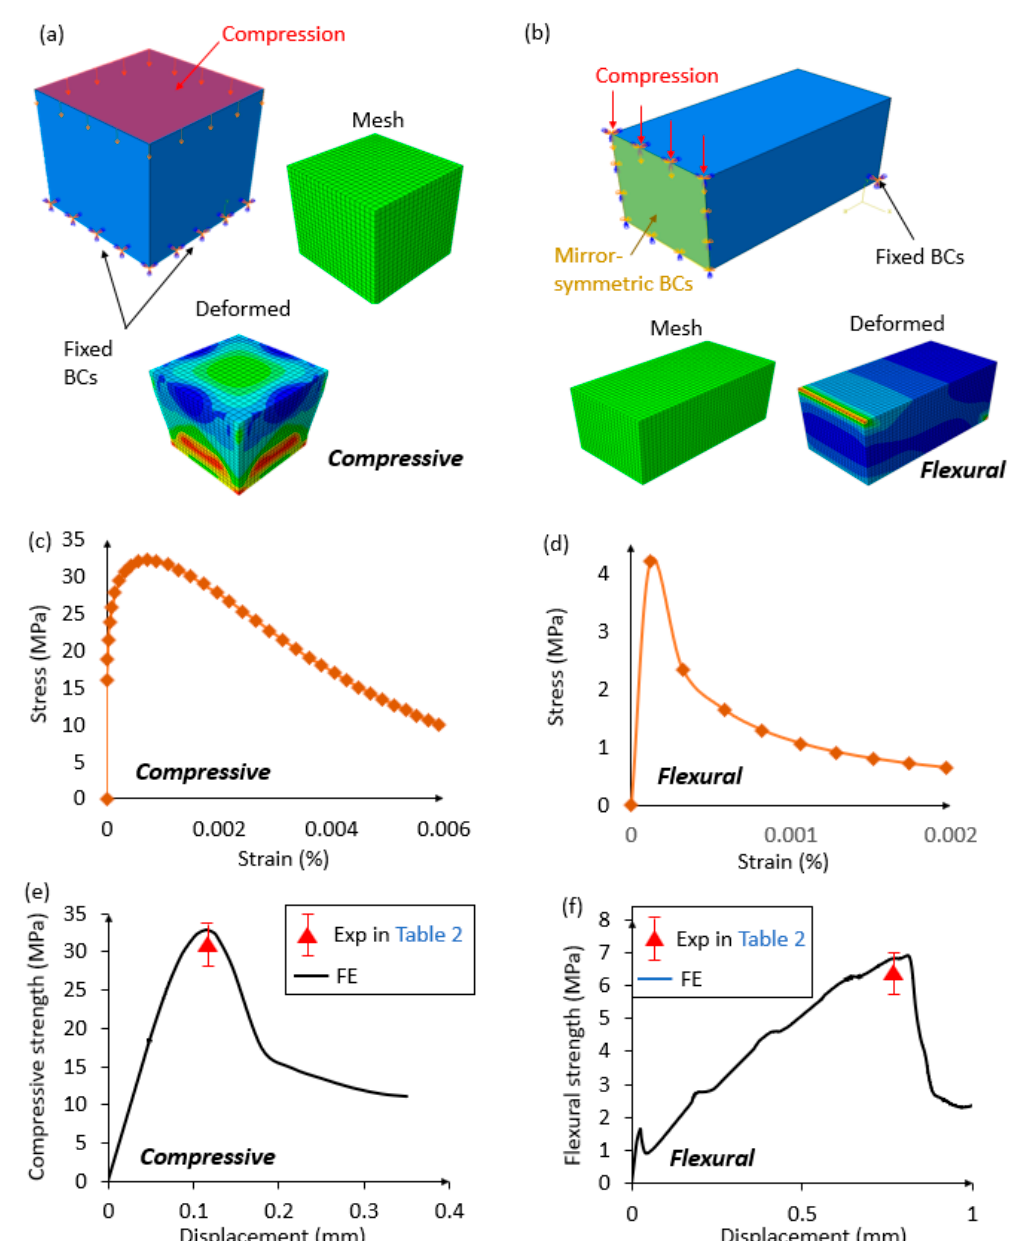
Figure 8. Loading and boundary conditions, mesh and deformed configurations of the OPC in the ( a ) compressive and ( b ) flexural testing. Experimentally measured ( c ) compressive and ( d ) tensile behaviors of the OPC specimens. Comparisons of the ( e ) compressive strength-displacement relation and ( f ) flexural strength-displacement relation for the OPC cured after 28 days between the experimental and numerical results (the experimental results are presented in Table 2 in bold and italic).